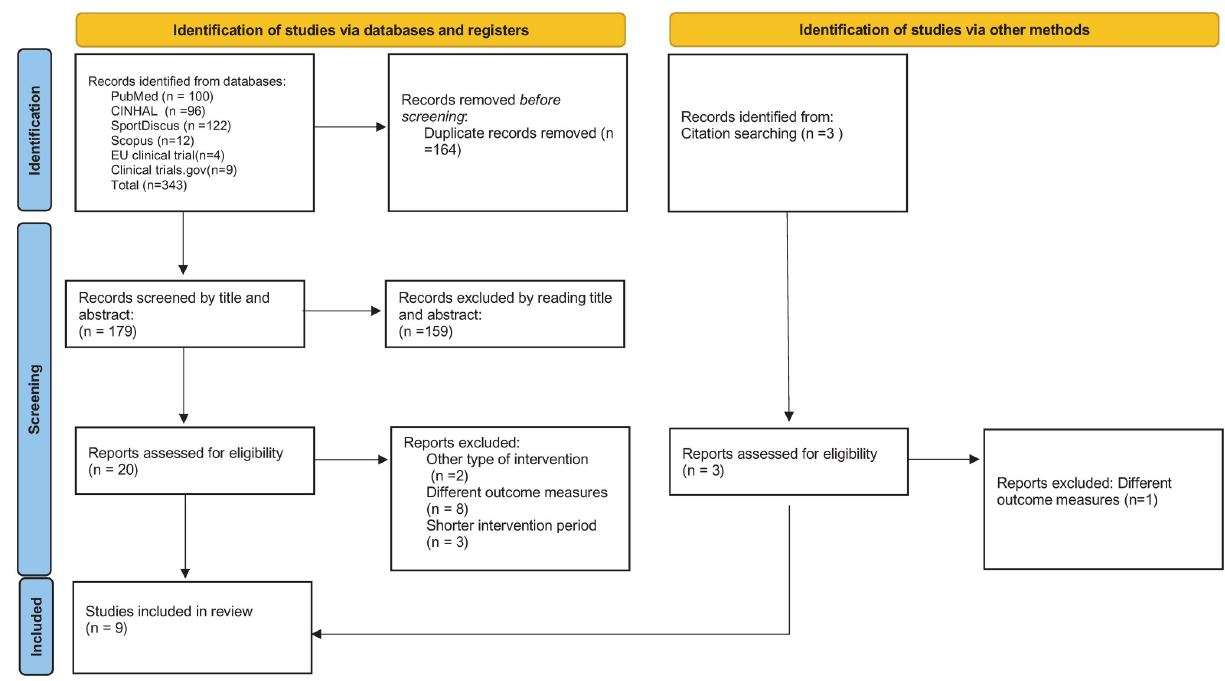
Fig 1. The PRISMA flow diagram of the study selection